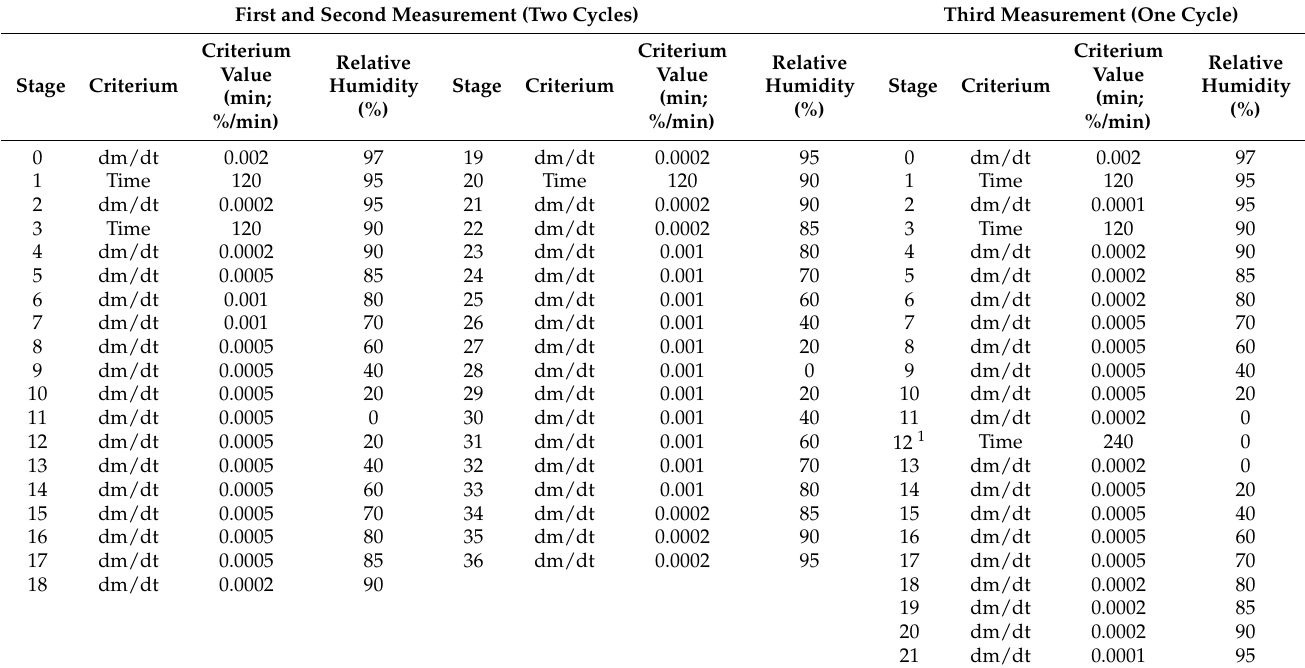
Table 4. DVS method